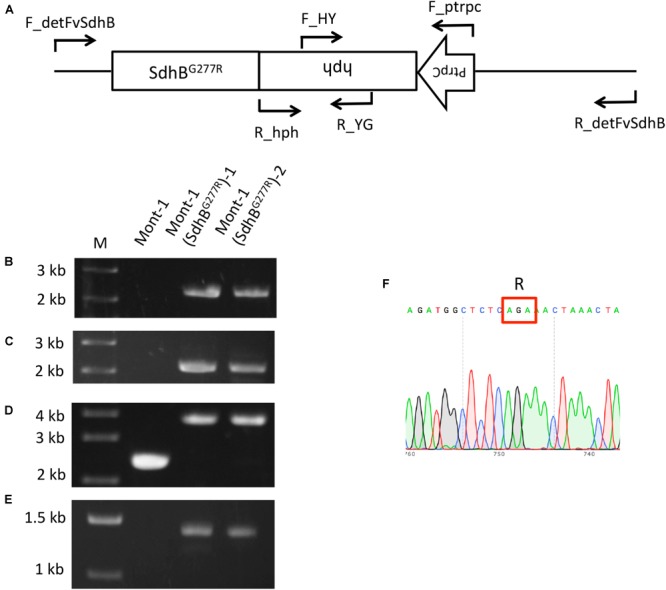
Validation of F. virguliforme mutants Mont-1(SdhBG277R)-1 and -2. (A) Schematic diagram of the SdhB gene and hygromycin resistance cassette (PtrpC and hph) and short arrows indicate primer binding sites. (B) Primer pair F_detFvSdhB/R_YG was used to amplify the 2,058-bp fragment of the left flanking region. (C) Primer pair F_HY /R_detFvSdhB was used to amplify the 2,171-bp fragment of right flanking region. (D) Primer pair F_detFvSdhB/R_detFvSdhB was used to amplify the fragment containing upstream and full length of SdhB, hygromycin resistance cassette, and downstream of SdhB (3,763-bp). (E) Primer pair F_ptrpC/R_hph was used to amplify the hygromycin resistance cassette (1,391-bp). (F) The sequence of the fragment from F_detSdhB/R_detSdhB in the strain Mont-1(SdhBG277R)-1 indicated the successful replacement from SdhB-277G to SdhB-277R.